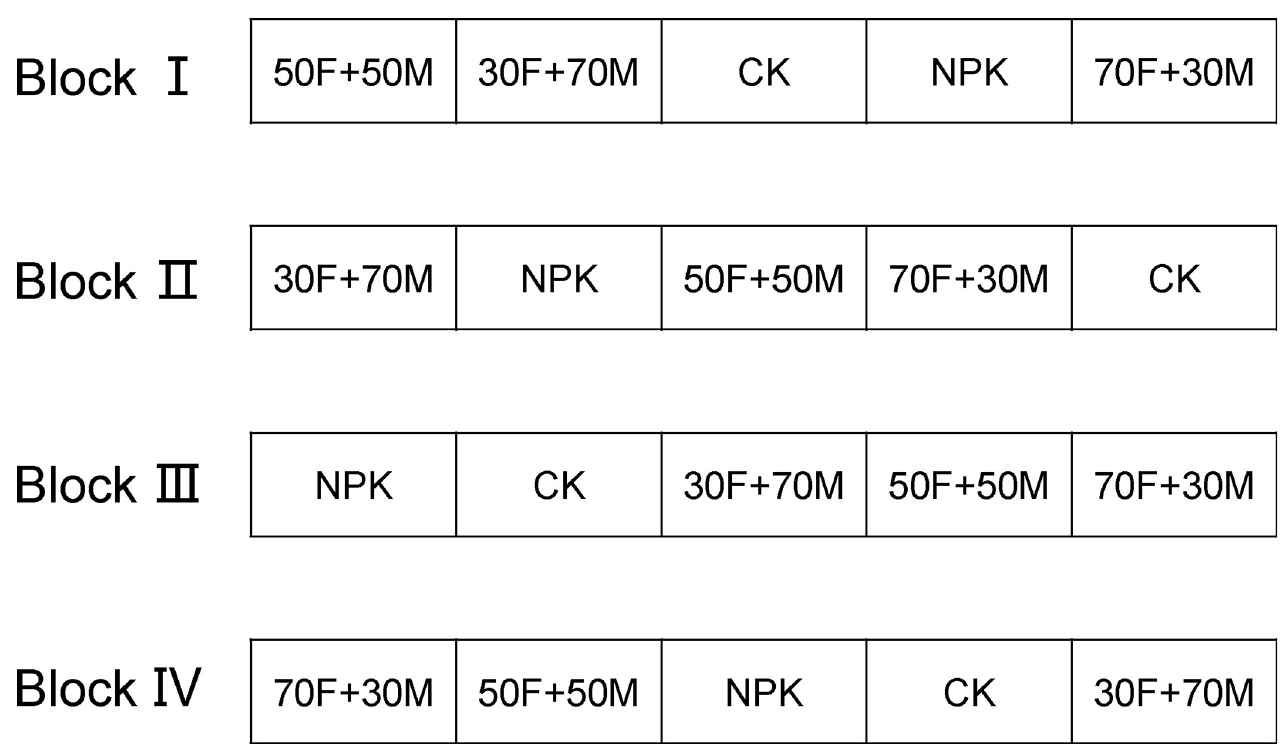
Fig 1. Schematic diagram of planting zoning. Each plot was 33.3 m 2 with 0.5m × 0.5m cement ridges around the block. Each block as a repeat. CK: non- fertilization group; NPK: balanced inorganic fertilization; 70F+30M: 70% chemical and 30% organic fertilizer group; 50F+50M: 50% chemical and 50% organic fertilizer group; 30F+70M: 30% chemical and 70% organic fertilizer group.